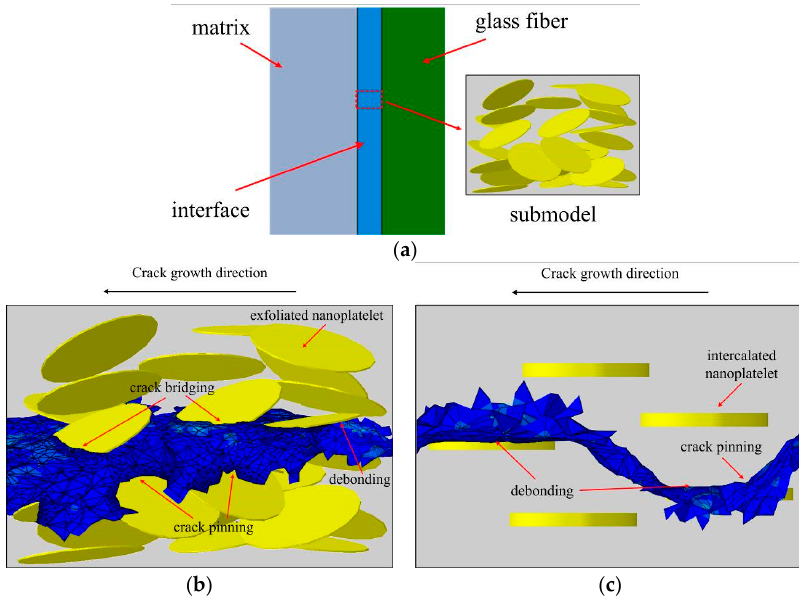
Figure 10. Example of a unit cell model of CNT-reinforced hybrid composite. Reprinted from [62] with kind permission of Elsevier.